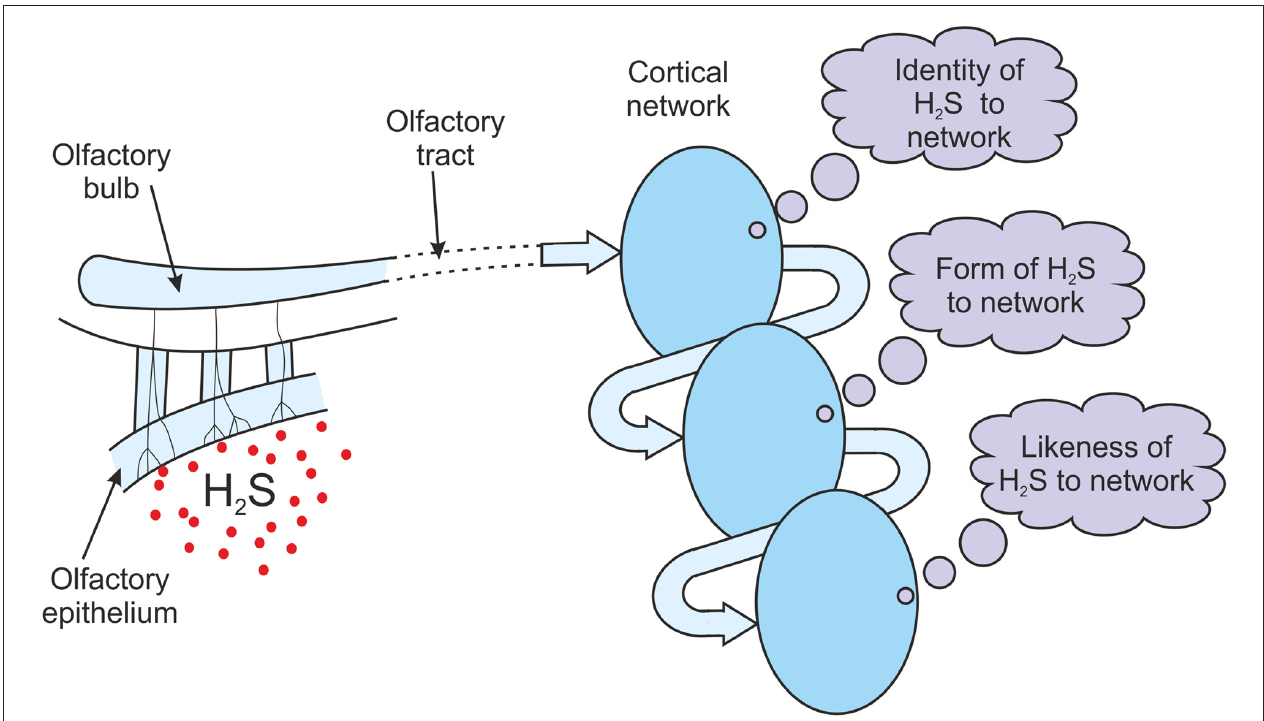
FIGURE 7 | The generation of olfactory qualia. Following exposure to H 2 S, information structures from the olfactory tract are cycled through a cortical olfactory network. If attention can lead to an attractor state in this network, the message obtained with each pass of information builds on the previous message. The message evolves from an inner identity of H 2 S, to an inner form of H 2 S, to an inner likeness or image of H 2 S. H 2 S-ness is